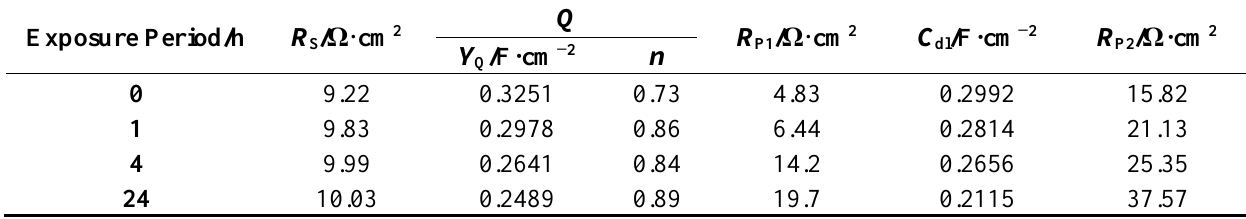
Table 3. EIS parameters obtained for γ-TiAl alloy in 3.5% NaCl solutions at room temperature. Exposure